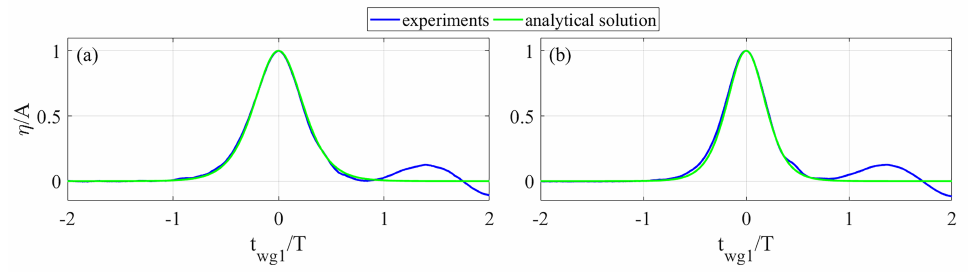
Figure 3. Comparison between experimental and analytical time series of surface elevation η at wg1. ( a ) Test no. 8; ( b ) test no. 18.